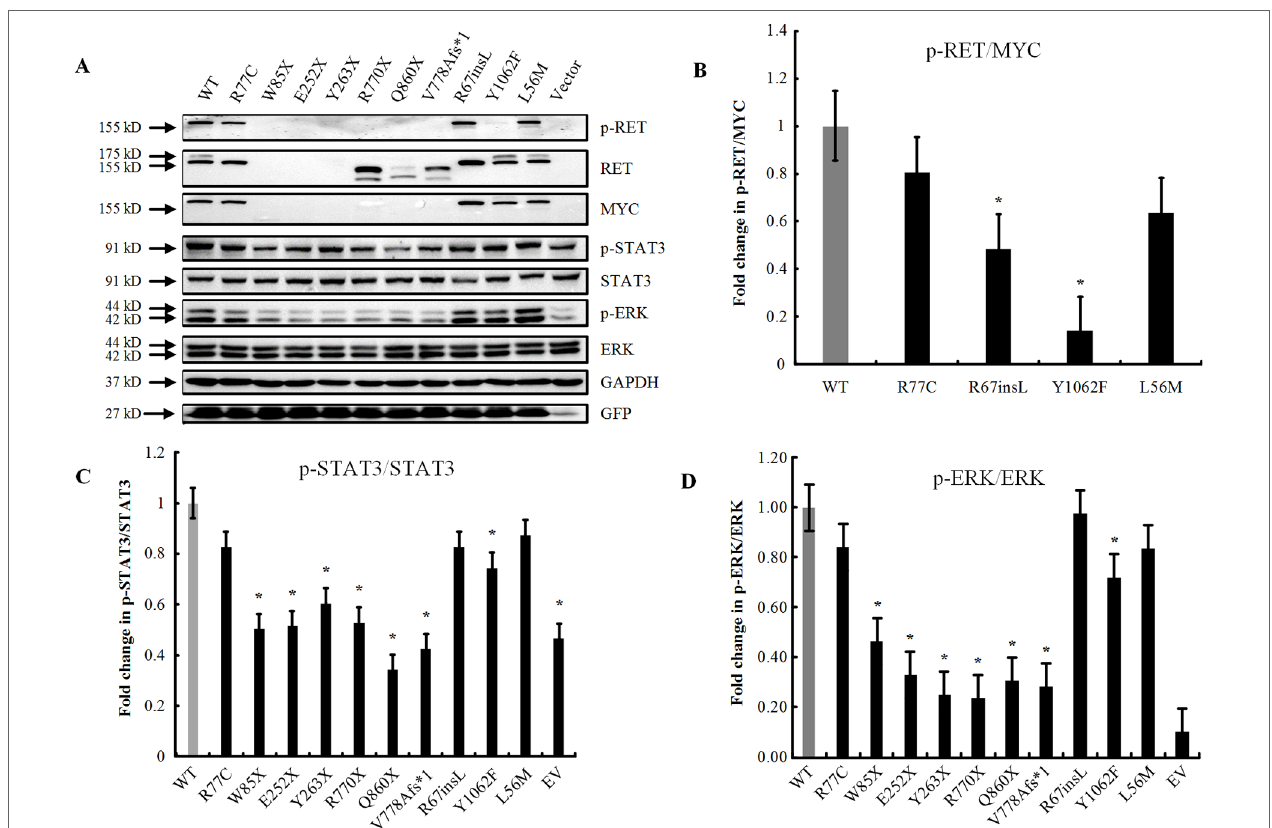
FIGURe 2 | Effect of the mutation on RET glycosylation and phosphorylation. (a) Western blot analysis of the lysates of HEK293T cells transfected with RET-WT or RET-mutants: p.R77C, p.W85X, p.E252X, p.Y263X, p.R770X, p.Q860X, p.V778Afs*1, p.R67insL, and empty vector (EV). Two mutants were included in this experiment as positive (p.Y1062F) and negative (p.L56M) controls. (B) Densitometric analysis of p-RET and MYC. Values were normalized using GFP and GAPDH. (C) Densitometric analysis of p-STAT3 and STAT3. Values were normalized using GFP and GAPDH. The expression of p-STAT3 is shown as the fold change relative to STAT3 expression . (D) Densitometric analysis of p-ERK and ERK. Values were normalized using GFP and GAPDH. The expression of p-ERK is shown as the fold change relative to ERK expression. Three independent experiments were performed for each condition (N = 3, * P < 0.05).